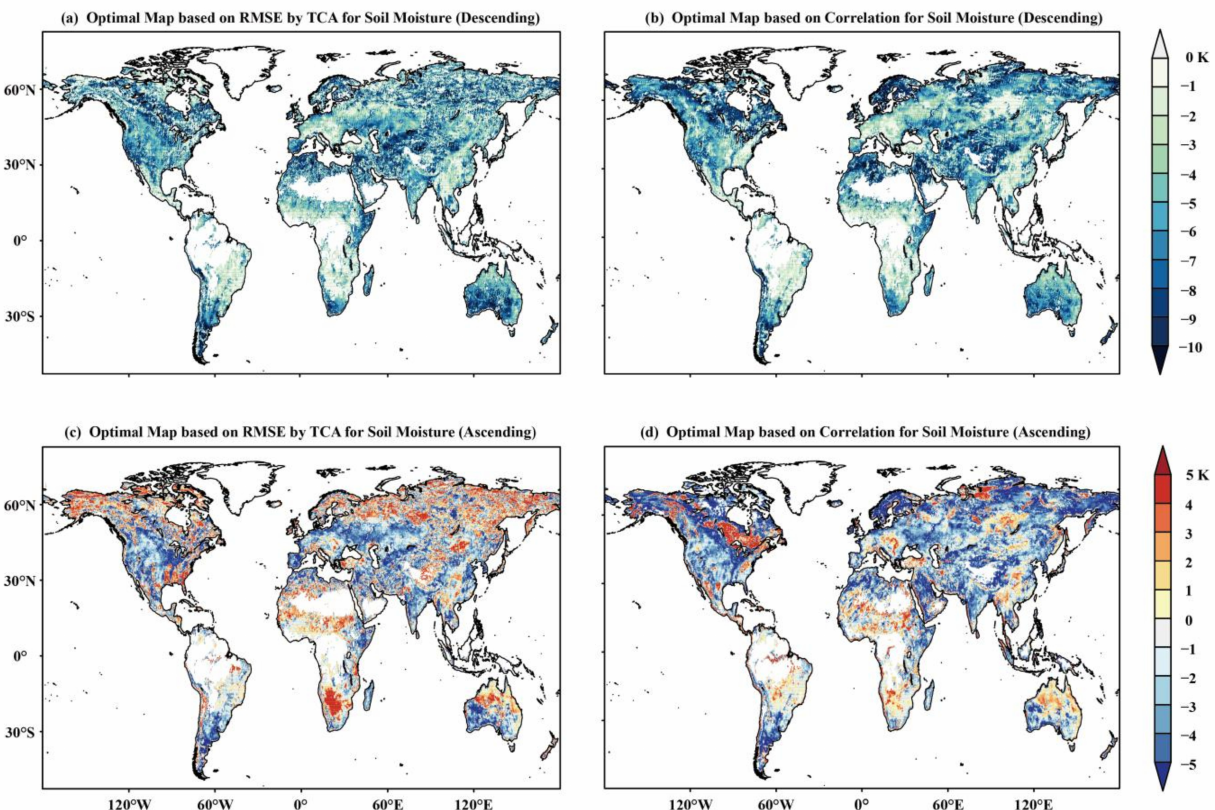
Figure 3. The spatial distribution maps of SM in FY-3C data obtained from the different LST bias scenarios. ( a ) Optimal map based on RMSE by TCA for descending data (unit: m 3 m − 3 ); ( b ) optimal map based on correlation for descending data; ( c ) optimal map based on RMSE by TCA for ascending data (unit: m 3 m − 3 ); ( d ) optimal map based on correlation for ascending data (white areas are not taken into consideration due to too few